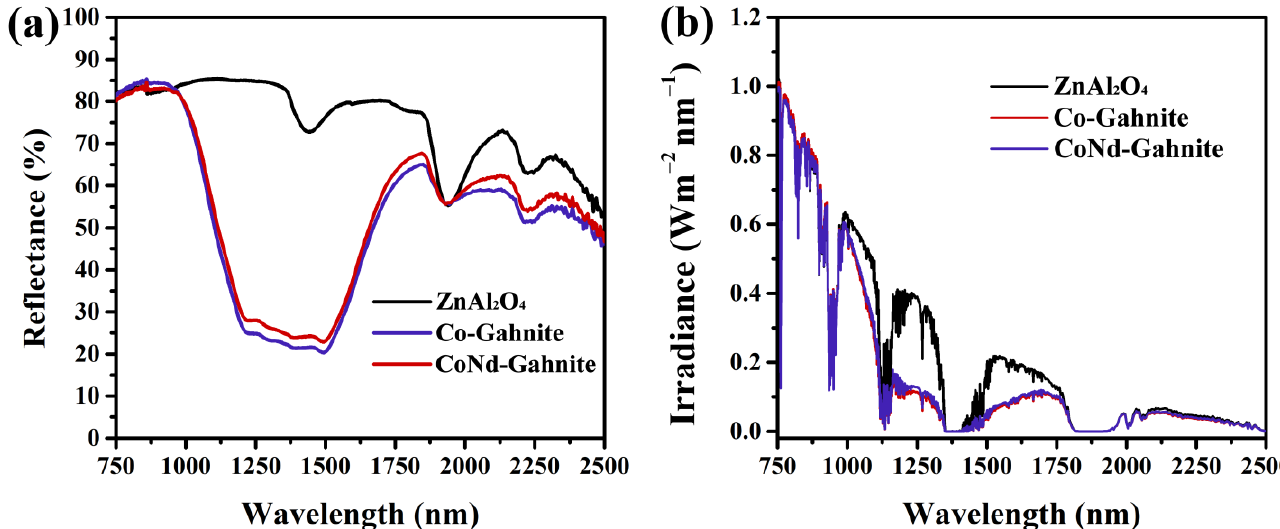
Figure 6 . ( a ) Diffuse reflectance spectra of the synthesized pigments in powder form, and ( b ) NIR solar reflectance spectrum of the powder pigments adjusted to the standard solar spectrum. Table 2. Color Coordinates and NIR Reflectivity of Co-Gahnite, CoNd-Gahnite, and other blue pig- ments with the synthesis method employed.